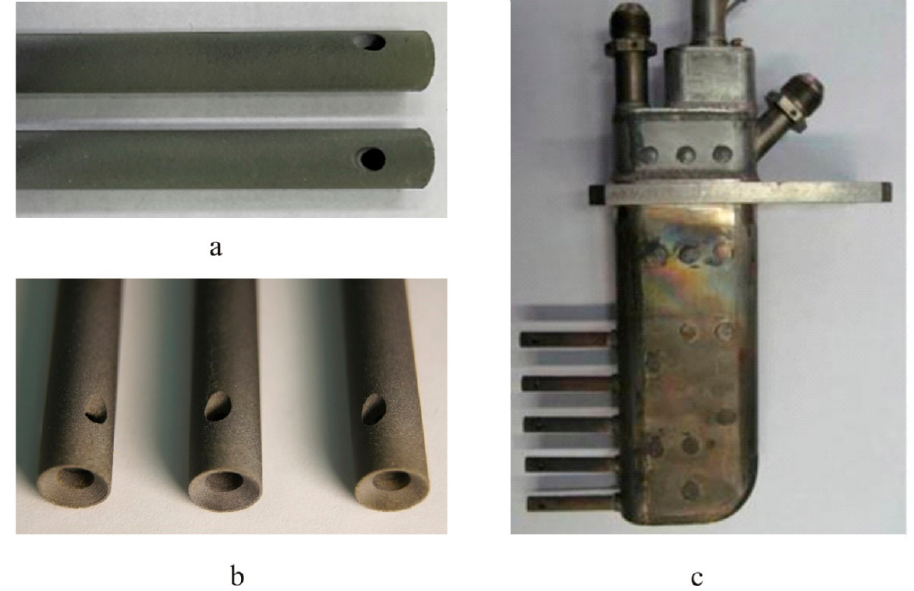
Figure 11. Thermal probes for temperature measurement in a high-temperature gas flow with brake chambers ( a , b ) and a comb with thermal probes as an assembly ( c ).